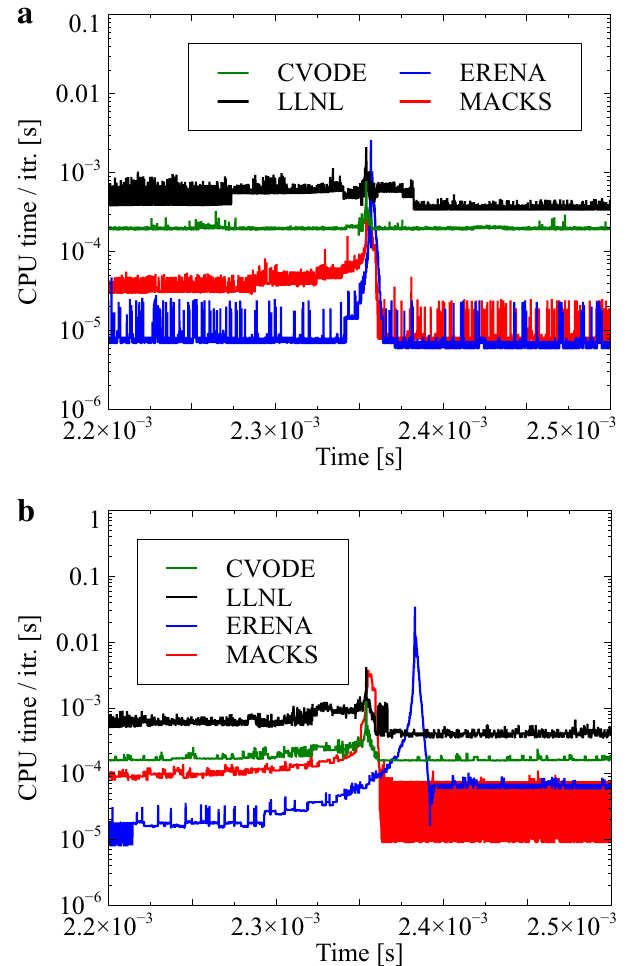
Figure 7. Time histories of computational cost per one-iteration with CVODE, LLNL, ERENA, and MACKS for a CH 4 /air mixture with h = 1 × 10 −